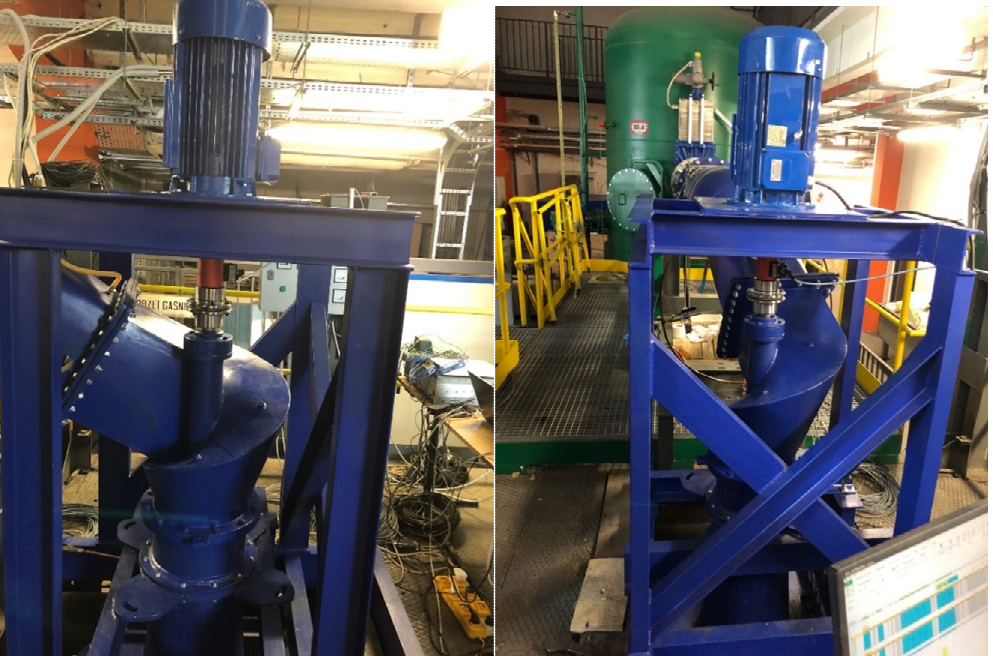
Figure 11. Views from the side ( left ) and from the side opposite to the water inflow ( right ) of the intake system, supply spiral and runner segment of the model semi-Kaplan turbine.